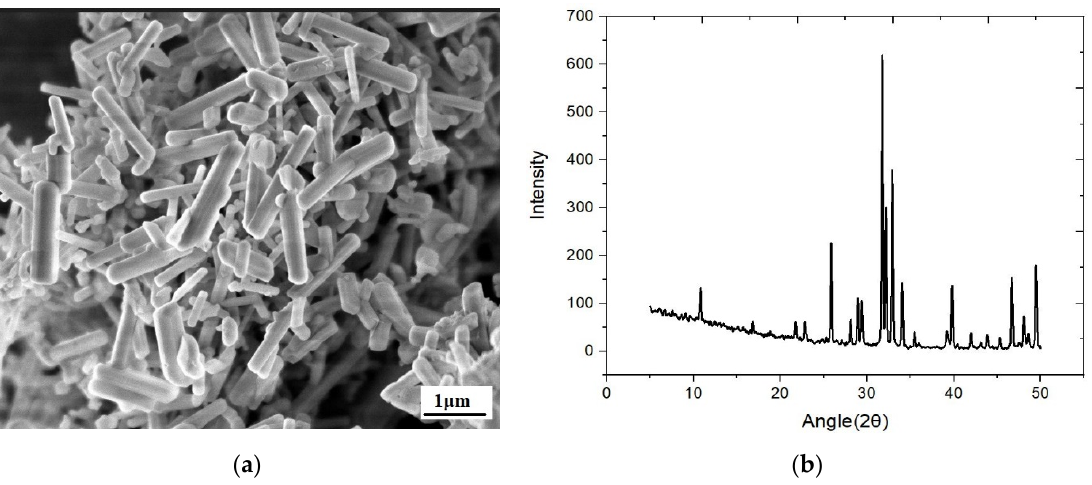
Figure 1 . ( a ) SEM image of Hydroxyapatite nanorods, ( b ) X ‐ ray diffraction spectrum. Figure 1. ( a ) SEM image of Hydroxyapatite nanorods, ( b ) X-ray diffraction